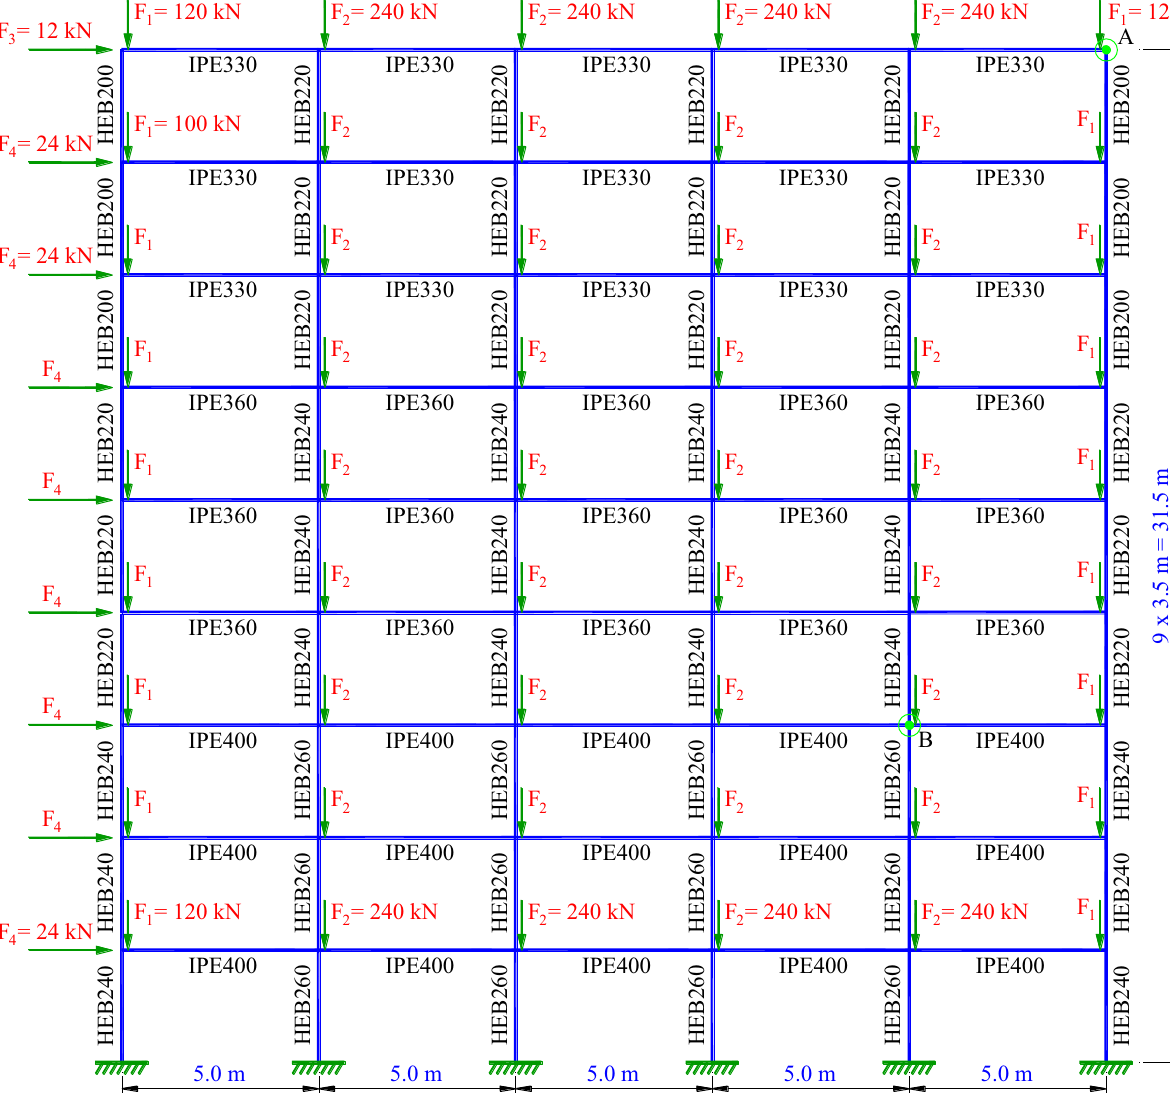
Fig. 25 Five-bay nine-story